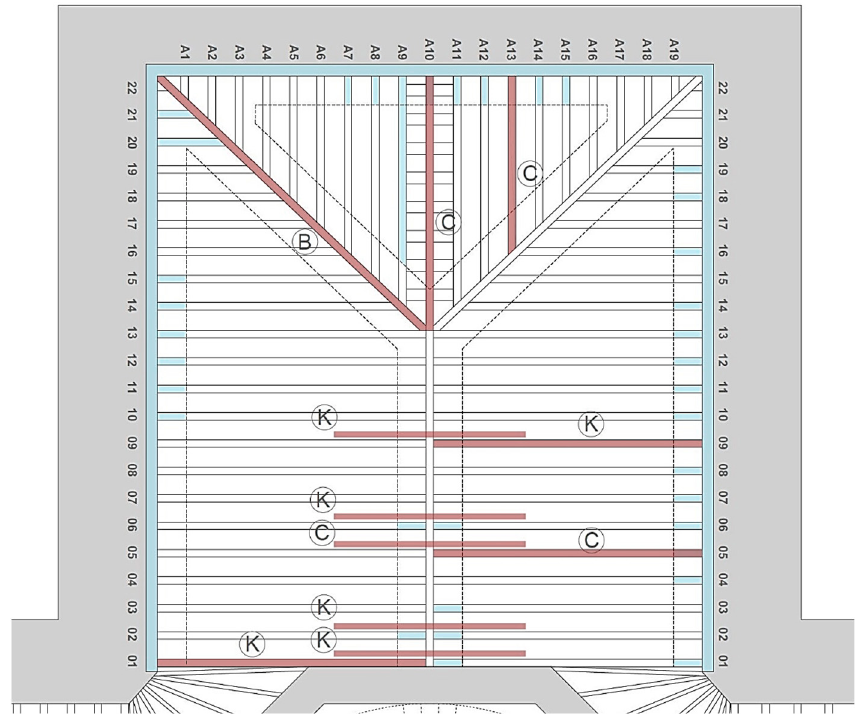
Figure 16. Visual classification results and areas with high MC. The rejected elements are shown in red; at the circles, we have the reason. C = Checks; K = Knots; B = Biological attack. Sections of pieces with high moisture levels are shown in blue.